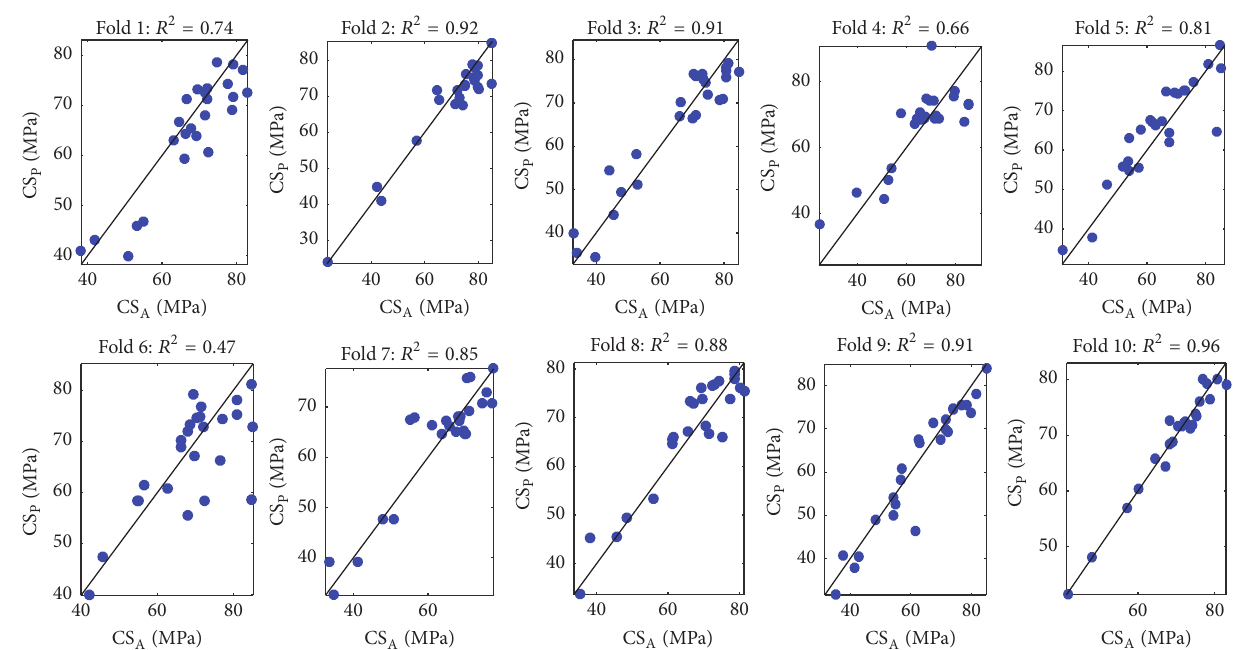
Figure 5: ANN prediction result obtained from the 10-fold cross